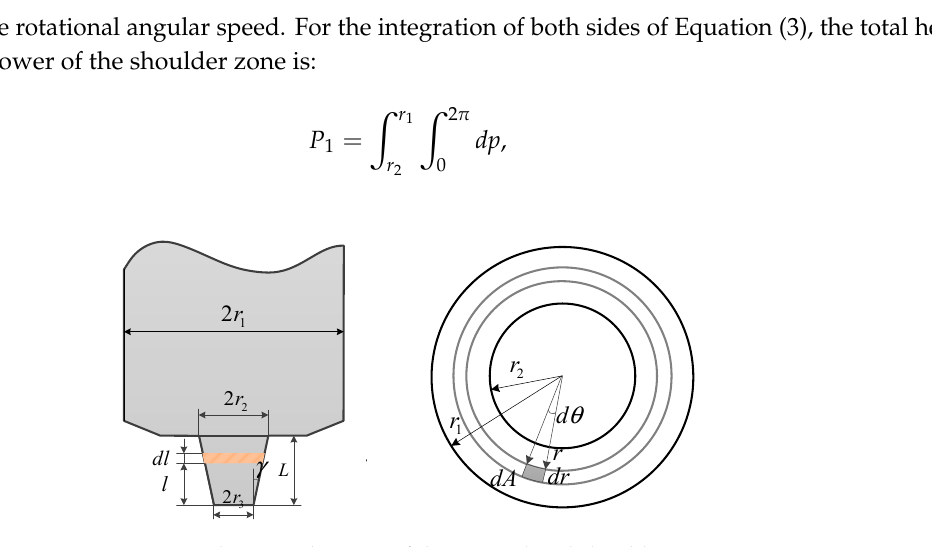
Figure 2. Schematic diagram of the pin and tool shoulder size. Table 1. Variables used in this